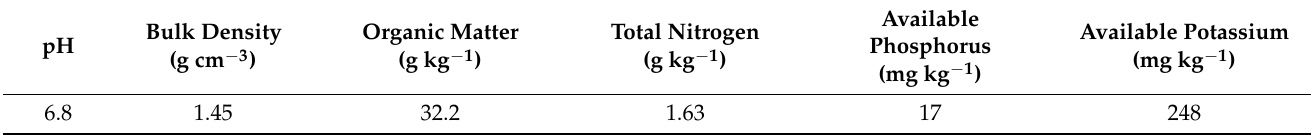
Table 1. Basic properties of soil fertility in experimental